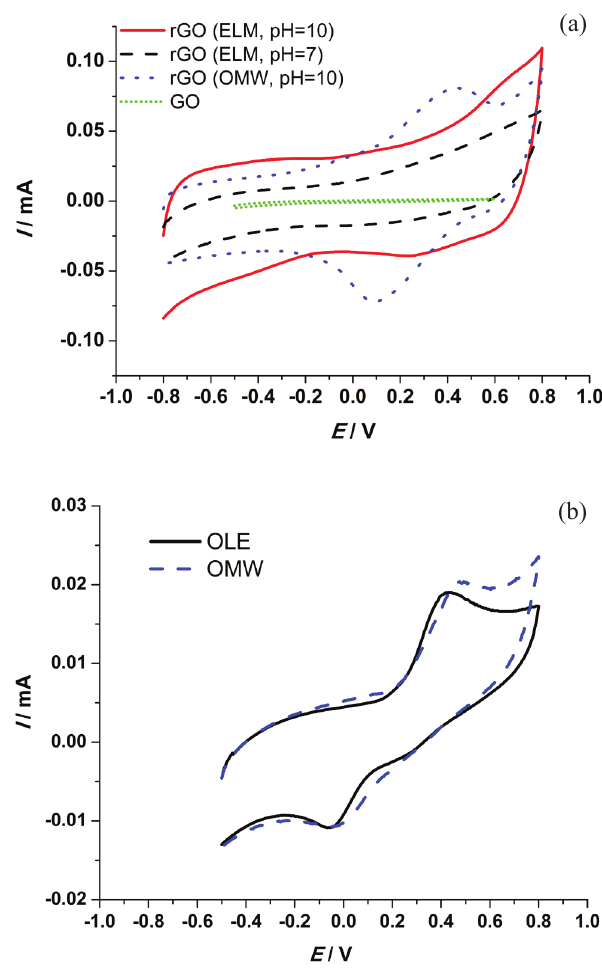
Fig. 4 – Cyclic voltammograms for a) different rGO elec- trodes in 0.5 mol dm –3 Na and OMW buffer solutions of pH=5.5, n =50 mV s –1